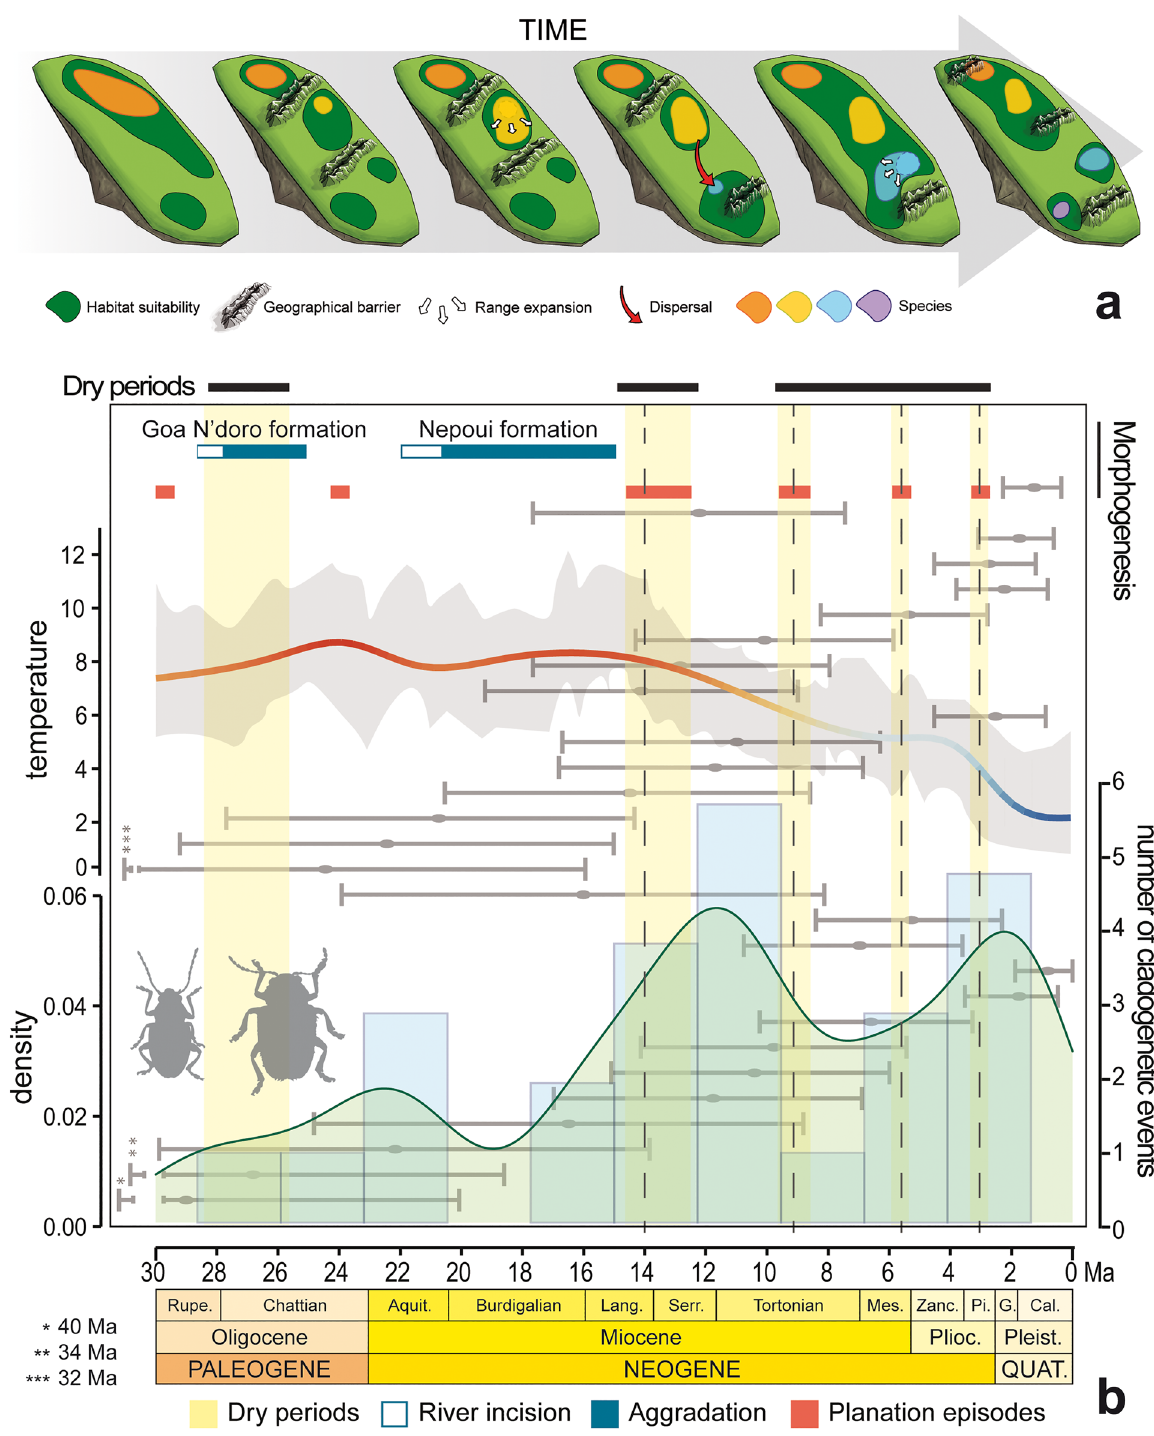
Figure 3. ( a ) Cartoon summary of the main spatial processes explained in the main text conducing to gradual occupation of habitat through successive speciation events and confinement to microendemic ranges in a scenario with reduced effects of extinction. ( b ) Histogram of the succession and variation in the number of phylogenetic splits along the evolution of Taophila and Tricholapita since the Oligocene, with gray horizontal bars showing confidence time intervals for these splits (shown in no particular order), together with contemporaneous palaeoenvironmental changes in temperature and precipitation regimes (pale yellow intervals and black bars on top) and major chronological periods of geomorphic evolution of Grande Terre (white, blue and red intervals), both based on the synthetic model of 74